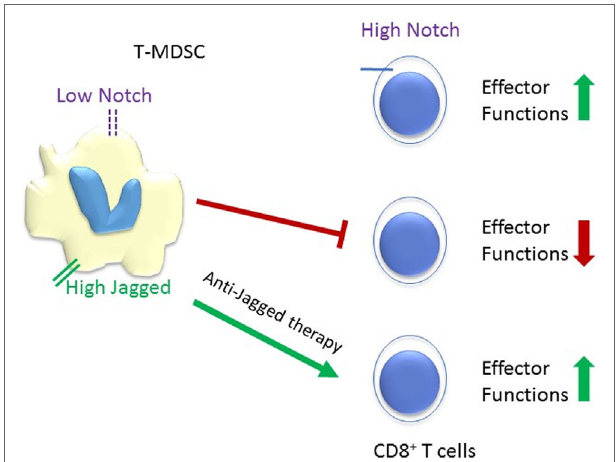
FigURe 2 | Schematic representation of the reciprocal responses of tumor-infiltrating MDSC (T-MDSC) and CD8 + T cells to Notch signaling. High Notch signaling promotes CD8 + T cells effector functions, while low Notch signaling spurs T-MDSC. Tumor microenvironments upregulate the expression of Notch ligand Jagged on T-MDSC and anti-Jagged therapy overcome tumor-induced T cells tolerance (36). It is unclear whether Jagged expressed in myeloid-derived suppressor cell (MDSC) competes with DLL ligands for Notch1 and Notch2 in CD8 T-cells, or potentially with TCR- induced ligand-independent activation. However, blockade of Jagged1 and 2 in MDSC restores CD8 effector